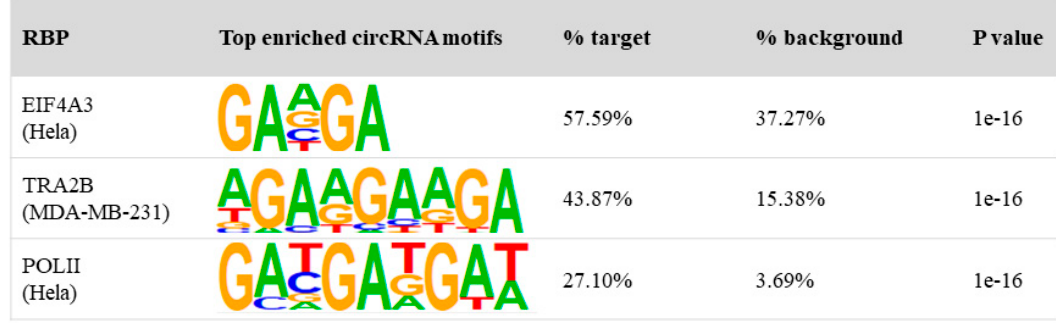
Figure 3. HOMER motif search results for EIF4A3, Tra2b, and Pol II. The left panel shows the protein and cell line / tissue information, the middle panel shows top circRNA motif and the right panel shows the p -values and percentages of sequences containing each motif. RBP, RNA binding proteins.